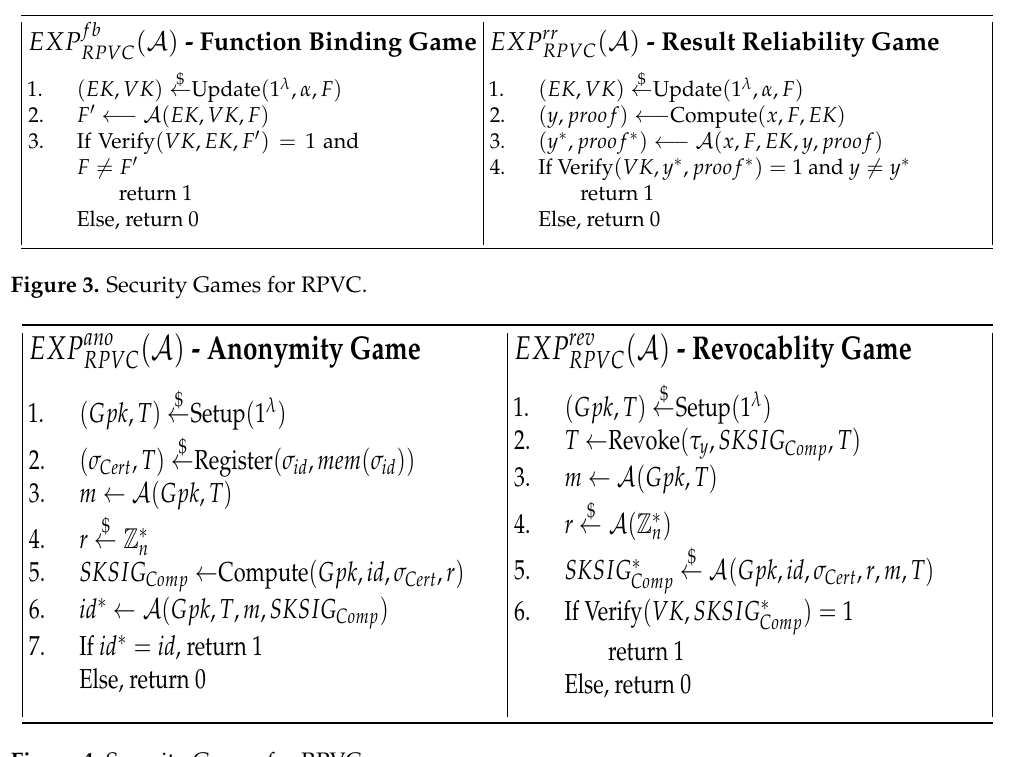
Figure 4. Security Games for